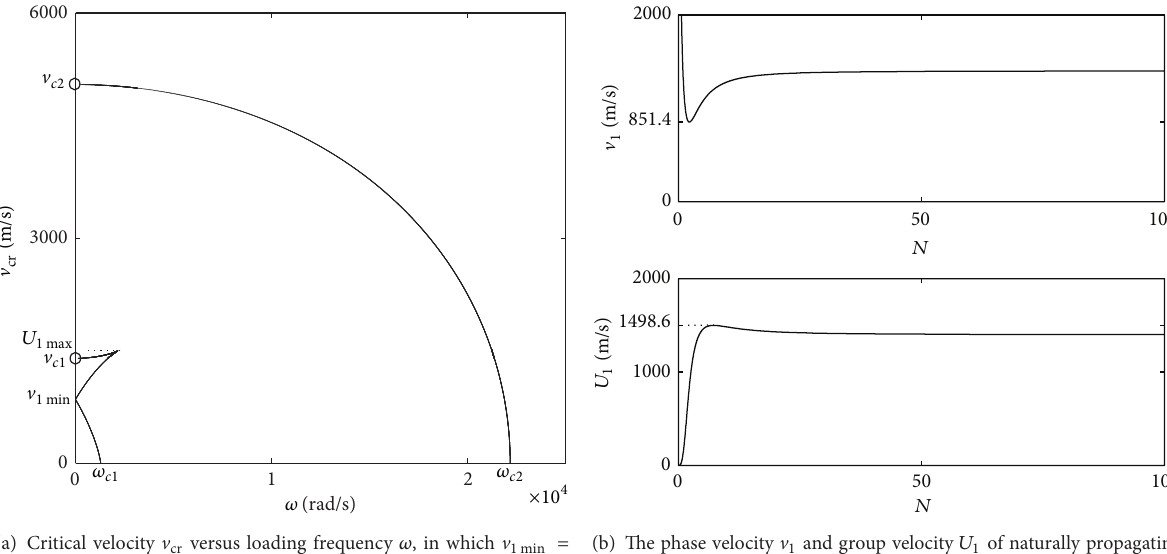
(b) The phase velocity V 1 and group velocity 𝑈 1 of naturally propagating waves versus wave number 𝑁 , V 1 min = 851.4 m / s, 𝑈 1 max = 1498.6 m/s